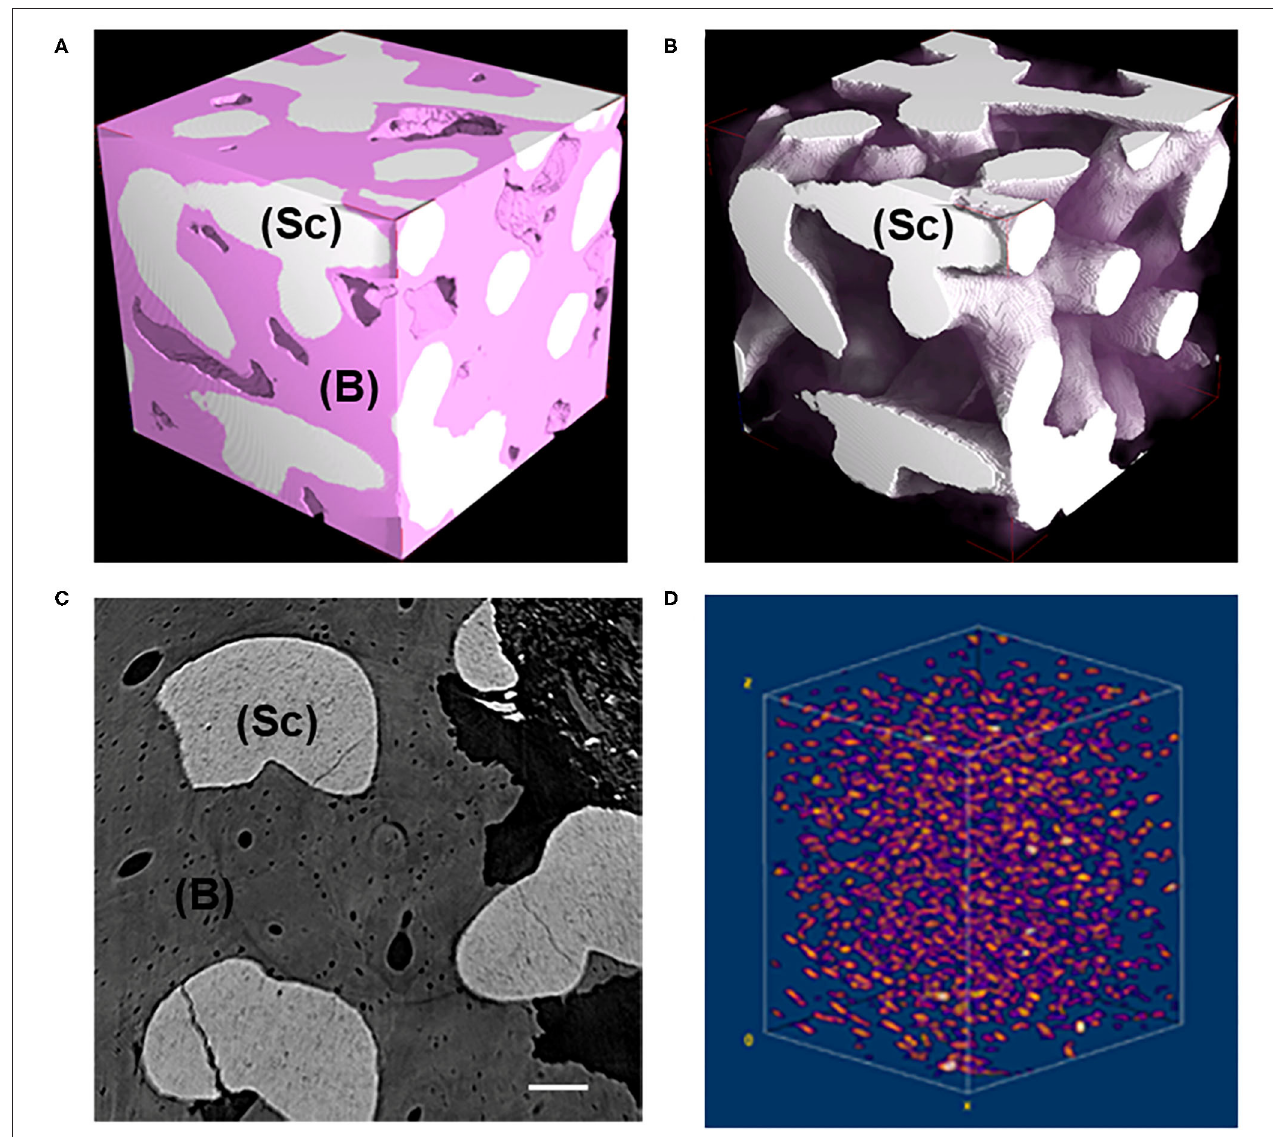
FIGURE 1 | (A,B) Representative 3D subvolumes as obtained at desktop microCT: (A) block-based TCP/HA scaffold as retrieved from in vivo test after 7 years; (B) same sample of (A) showing the residual scaffold not fully resorbed after 7 years in-vivo . Bone was virtually made transparent. Pink phase: bone; White phase: residual scaffold; (C) Representative transversal 2D section as obtained at synchrotron microCT; light gray phase: residual scaffold; dark gray phase: bone; black phase: medullar spaces; Scale bar = 100 µ m. (D) Representative 3D distribution of the osteocyte lacunae in a 3D bone subvolume, as obtained at synchrotron microCT. Sc, scaffold; B,